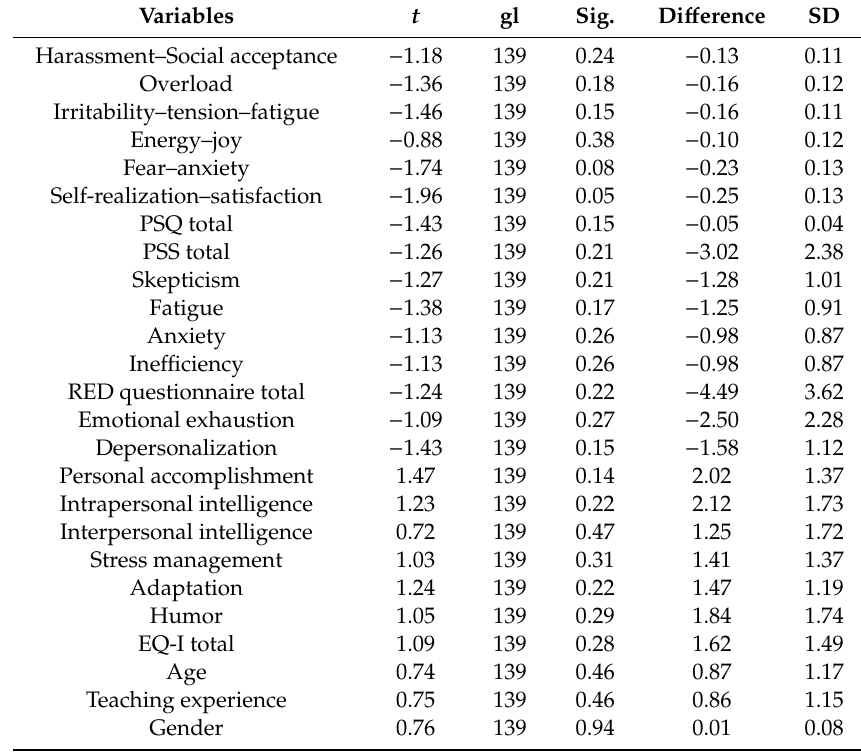
Table 2. Student’s t -test results for di ff erence in mean scores (before